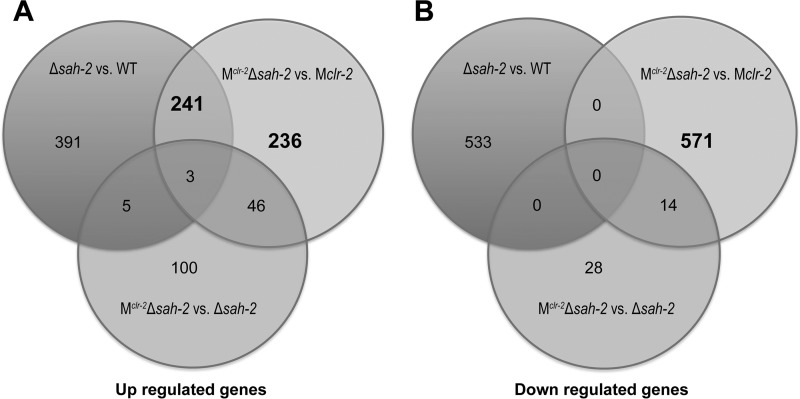
Analysis of sah-2 regulons. (A) Three-way Venn diagram pooling genes upregulated in the Δsah-2 mutant versus the WT, in Mclr-2 Δsah-2 versus Mclr-2, and in Mclr-2 Δsah-2 versus the Δsah-2 mutant. The threshold of differential gene expression was set as a ≥4-fold change (P ≤ 0.01). (B) Three-way Venn diagram pooling genes downregulated in the Δsah-2 mutant versus the WT, in Mclr-2 Δsah-2 versus Mclr-2, and in Mclr-2 Δsah-2 versus the Δsah-2 mutant. The threshold of differential gene expression was set as a ≥4-fold change (P ≤ 0.01).